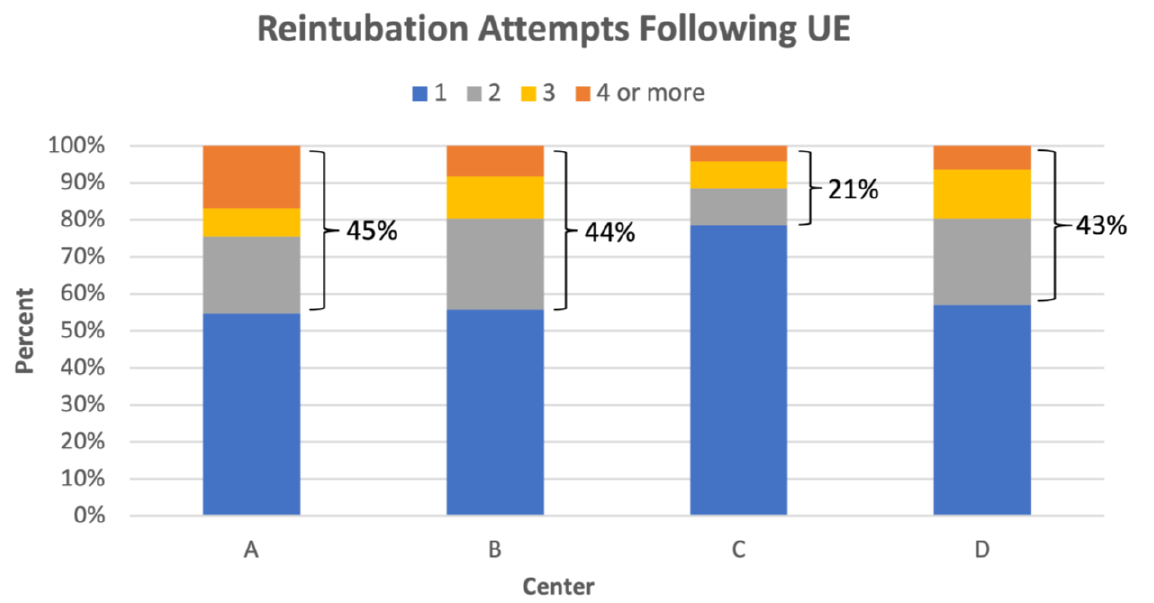
Figure 9. Percent distribution of number of intubation attempts following UEs at each center. The percentages bracketed beside each column represent the percentage of multiple intubation attempts.